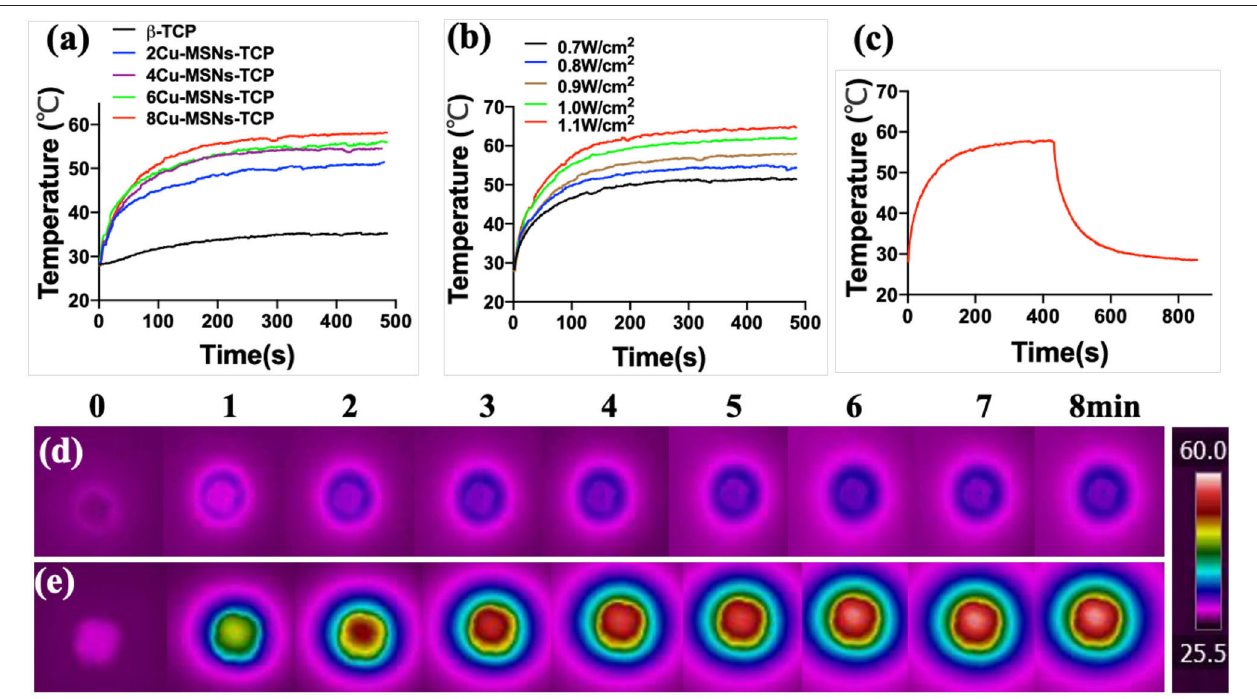
FIGURE 4 | Cu-containing mesoporous silica nanospheres modified β -tricalcium phosphate ( Cu-MSN-TCP) scaffolds exhibited a coating time-dependent (a) and laser power density-dependent (b) photothermal performance. The photothermal heating and cooling curve of 8Cu-MSN-TCP scaffolds under irradiation at 0.9 W/cm 2 (c) . Visual thermal images and temperature change of β -TCP (d) and 8Cu-MSN-TCP (e) scaffolds can be recorded and obtained using an infrared (IR) thermal